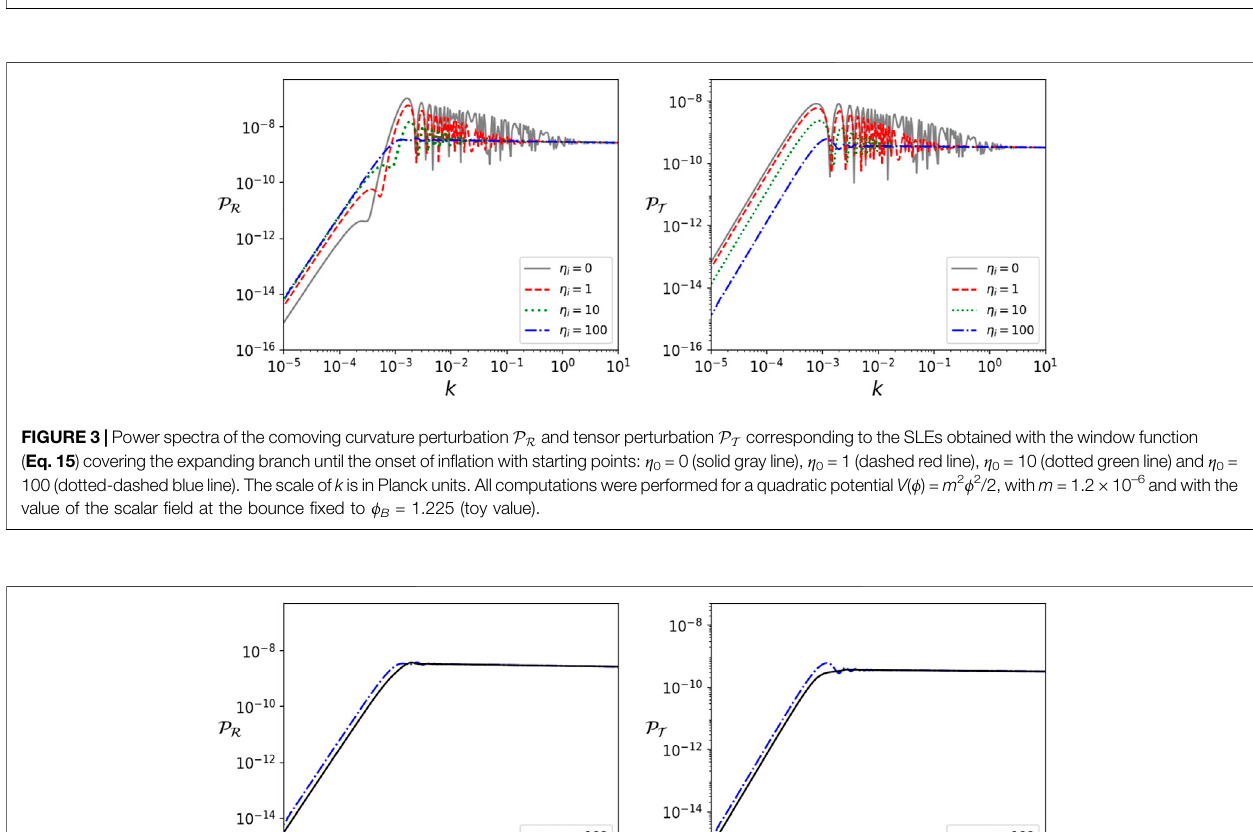
Figure 3 shows the corresponding primordial power spectra for scalar and tensor perturbations, computed through (9). Here, the effect of removing the bounce is evident. As the support of the